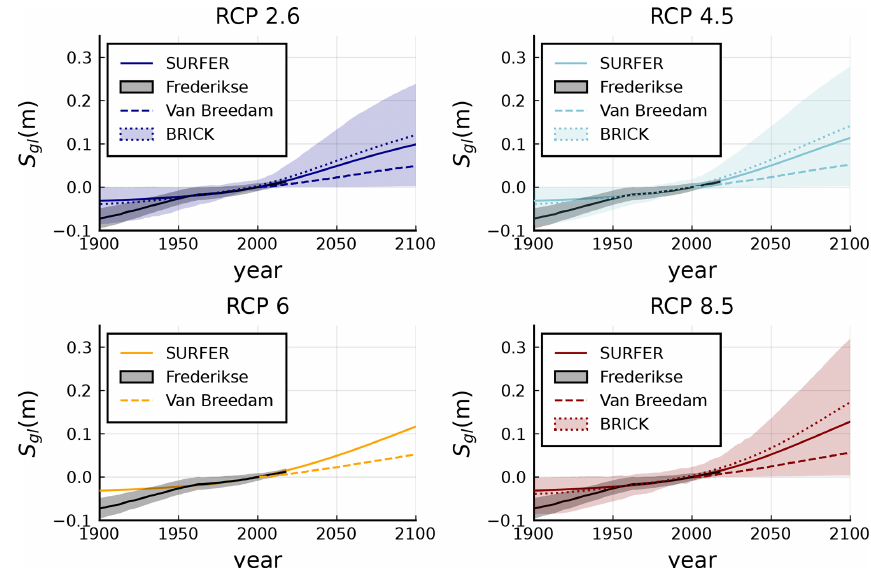
Figure 6. Sea level rise contribution from glaciers for historical period and projections along RCP scenarios. SURFER’s estimates correspond to the solid coloured lines, observations for the historical period from Frederikse et al. (2020a) are shown with solid black lines with the corresponding uncertainty range in grey shade. BRICK’s mean and uncertainty range are shown with dotted lines and coloured shades. The dashed lines correspond to results of Van Breedam et al. (2020). Sea level rise is with respect to year 2000.